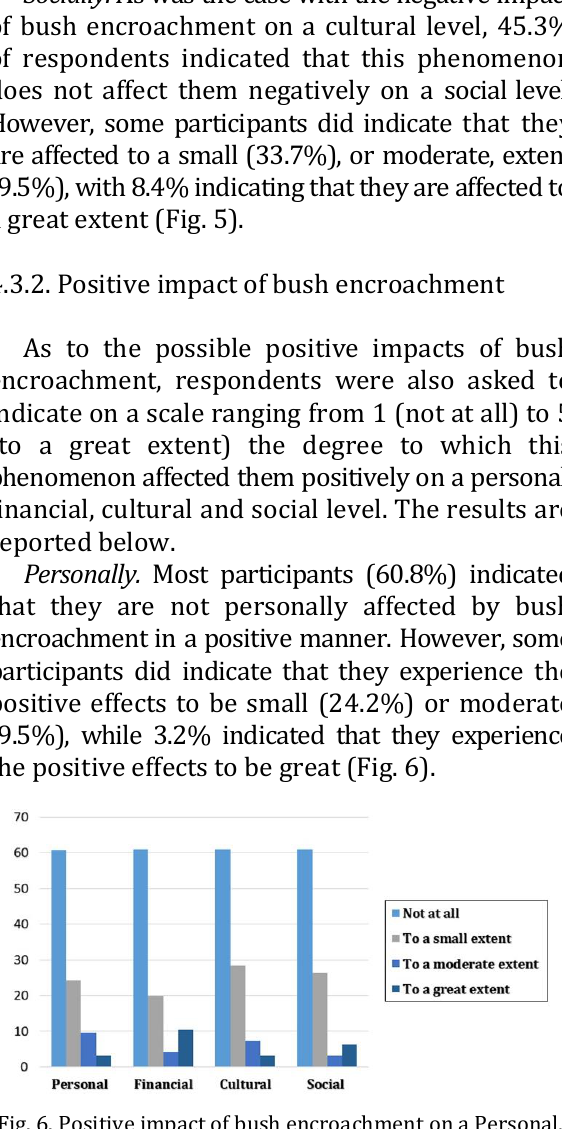
Fig. 6. Positive impact of bush encroachment on a Personal, Financial, cultural and social level (Source: own